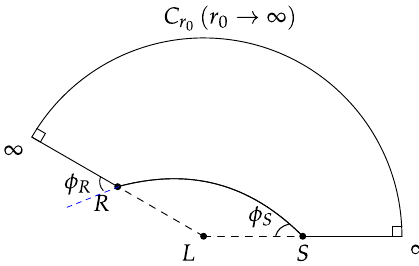
(cid:2) ∞ ⊂ ( ¯ M ,α ) . R, L and S denote the Fig. 1 The quadrilateral ∞ ij R S receiver, the lens and the source, respectively. (cid:16) R and (cid:16) S are angles between the particle ray tangent and the radial direction from the lens in R and S, respectively. The curve C r is defined by r (ϕ) = r 0 = 0 constant . Note that each outer angle at the intersection of the radial direction curves and C r is π/ 2, as r 0 → ∞ . Note that the jump angle 0 φ = π − (cid:16) φ = (cid:16) S S and R